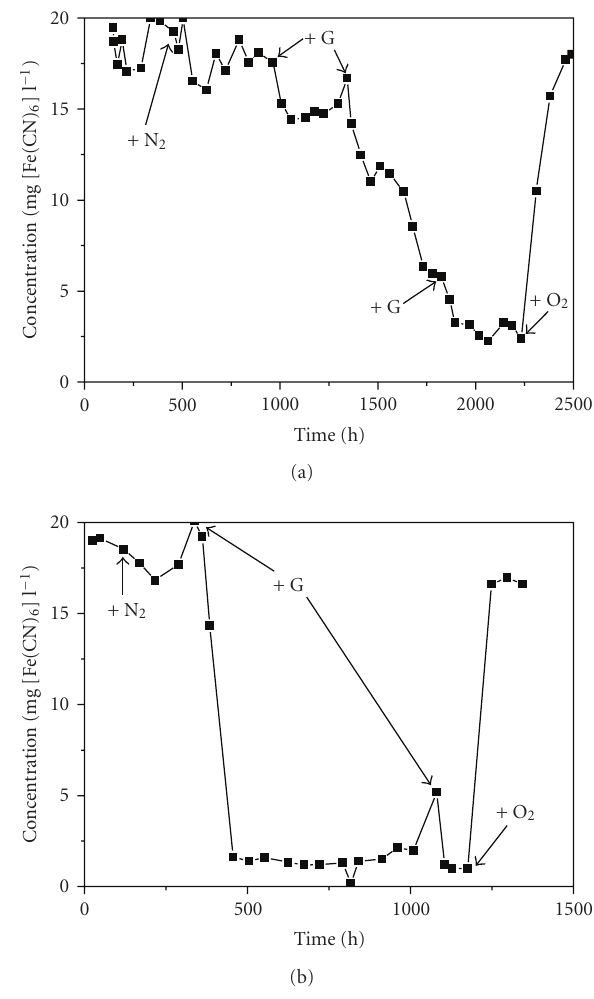
Figure 4: Total Fe-CN complex concentrations during the micro- cosm experiments (a) no. 1 and (b) no. 2. “+ G” denotes additions of glucose, “+ N 2 ” and “+ O 2 ” denote the gas purged through the